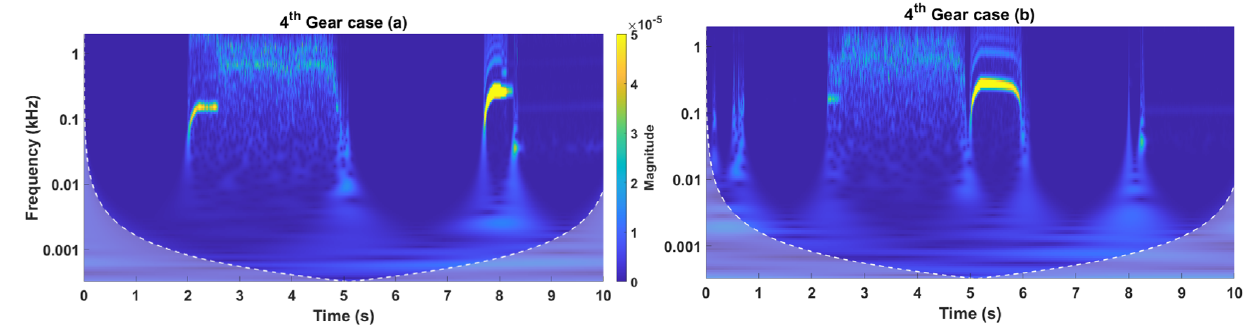
Figure 15. Time-Frequency Wavelet Transform: 4th